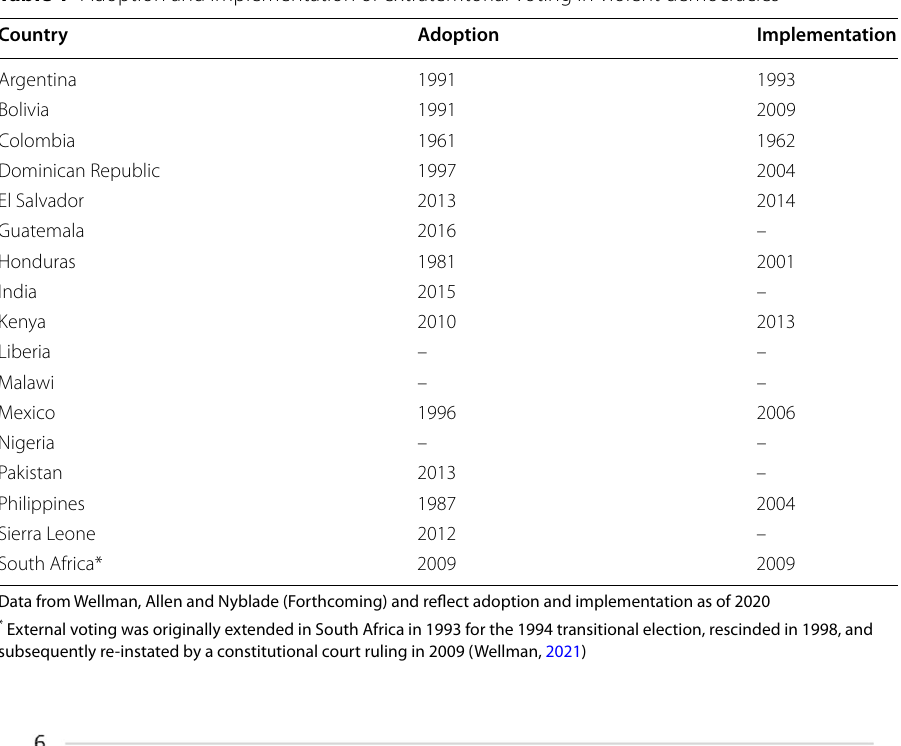
Table 1 Adoption and implementation of extraterritorial voting in violent democracies